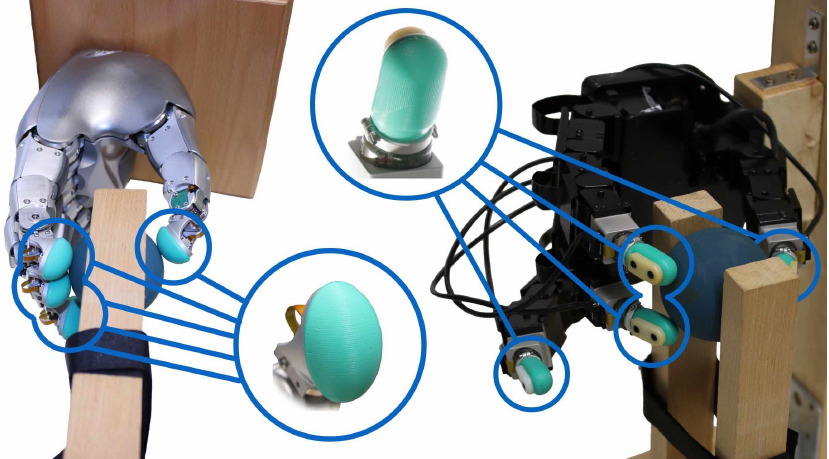
Figure 1. The proposed independent finger grip stabilization controller was successfully evaluated on the four-finger Allegro Hand (right) and on the five-finger Wessling Hand (left). The fingertips of both hands are equipped with Syntouch’s BioTac or BioTac SP sensors,